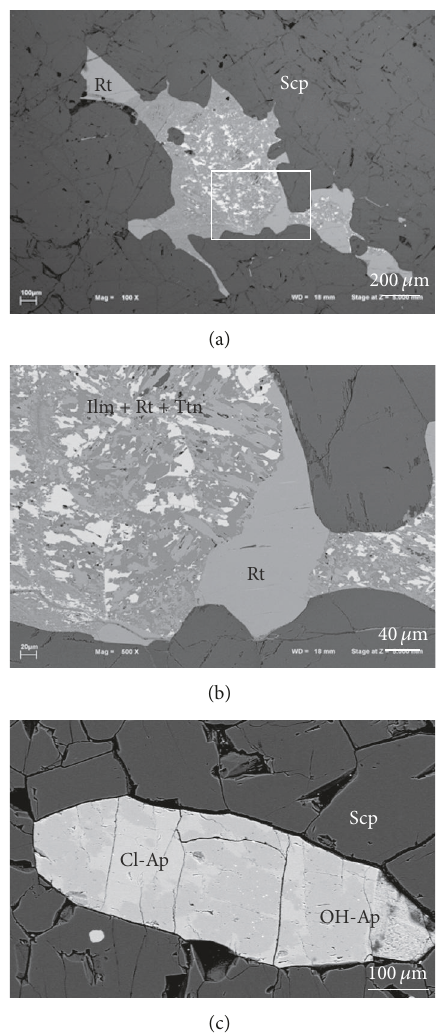
Figure 6: (a) Back-scattered electron (BSE) image of replacement of ilmenite by rutile in a scapolite metagabbro. Square indicates image in Figure 6(b). Sample 2Ø88.80, locality Ødeg˚arden Verk (photo: A. Korneliussen).(b)Detailofincompletealterationofilmenite(white) to rutile (light grey) and titanite (grey) (photo: A. Korneliussen). (c) BSEimageofClandhydroxyapatiteinscapolitemetagabbro.Sample 2Ø78.20, locality Ødeg˚arden